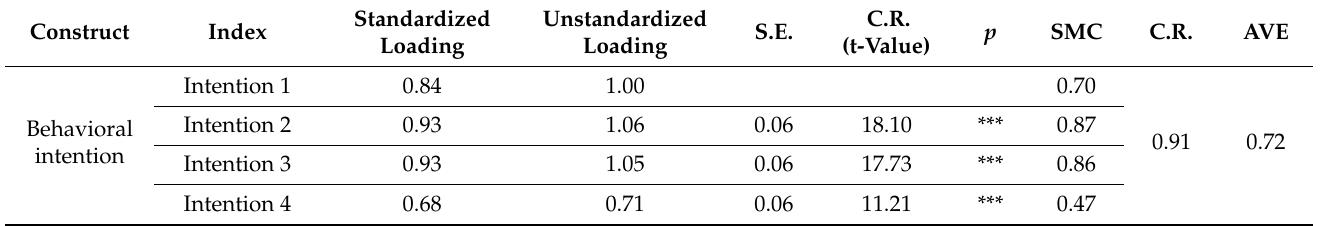
Table 5. Behavioral intention–verification analysis.